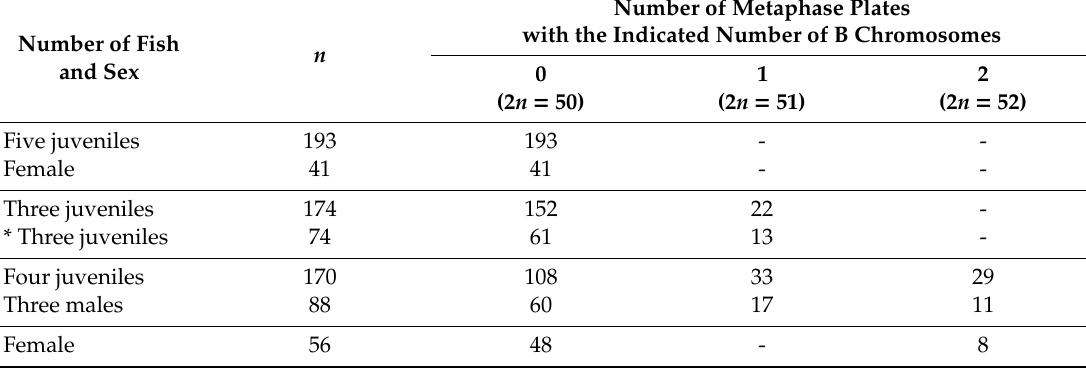
Table 1. The frequency of B chromosomes in the karyotype of Chondrostoma nasus ; Number of analyzed metaphase plates = n